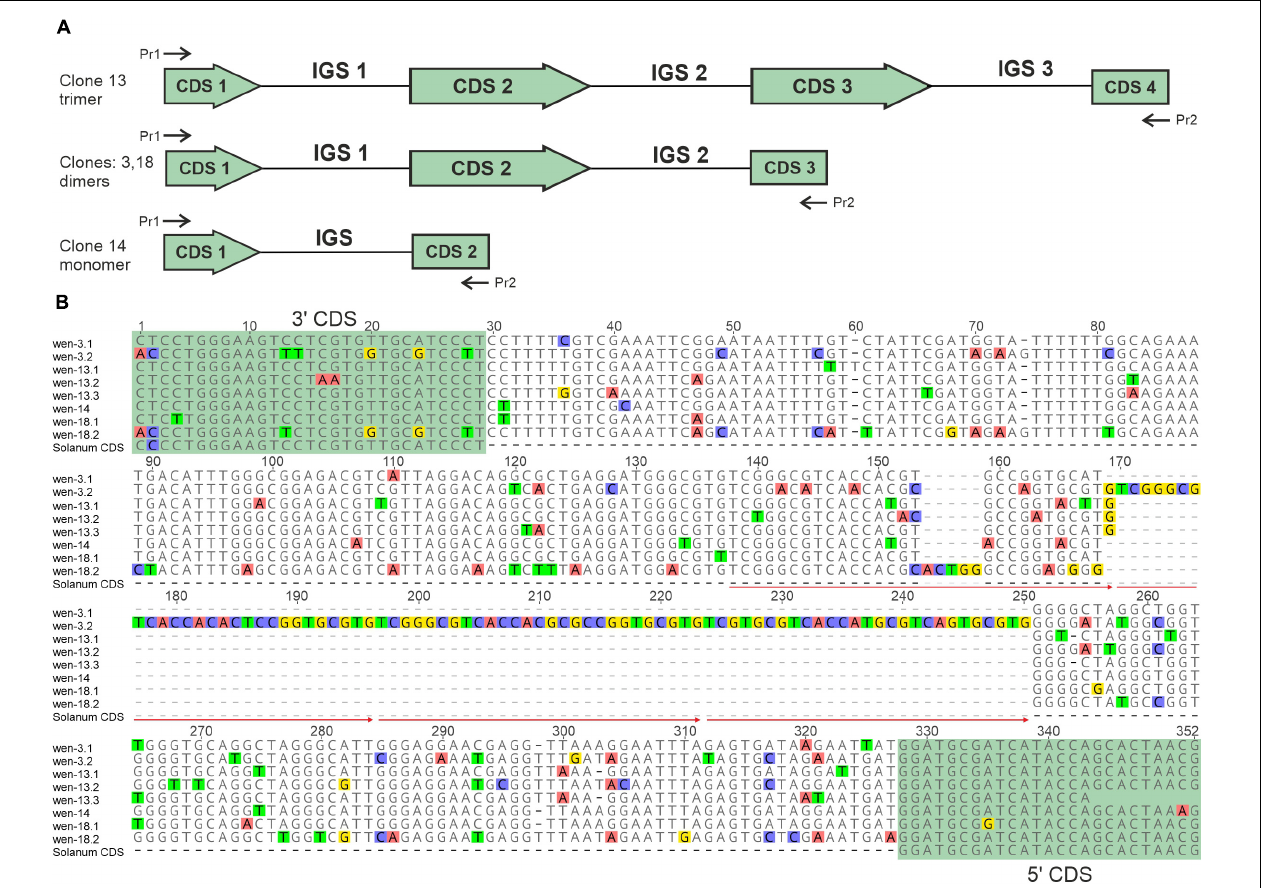
FIGURE 3 | Molecular organization of 5S rDNA repeats in S. wendlandii (wen). (A) General organization of 5S rDNA clones. Pr1 and Pr2, position of primers Pr5S-L and Pr5S-R used for PCR/cloning. (B) Sequences alignment of IGS and flanking fragments of CDS. The consensus sequence of CDS of the genus Solanum (Solanum CDS) is shown for comparison. The arrows indicate the location of repeated